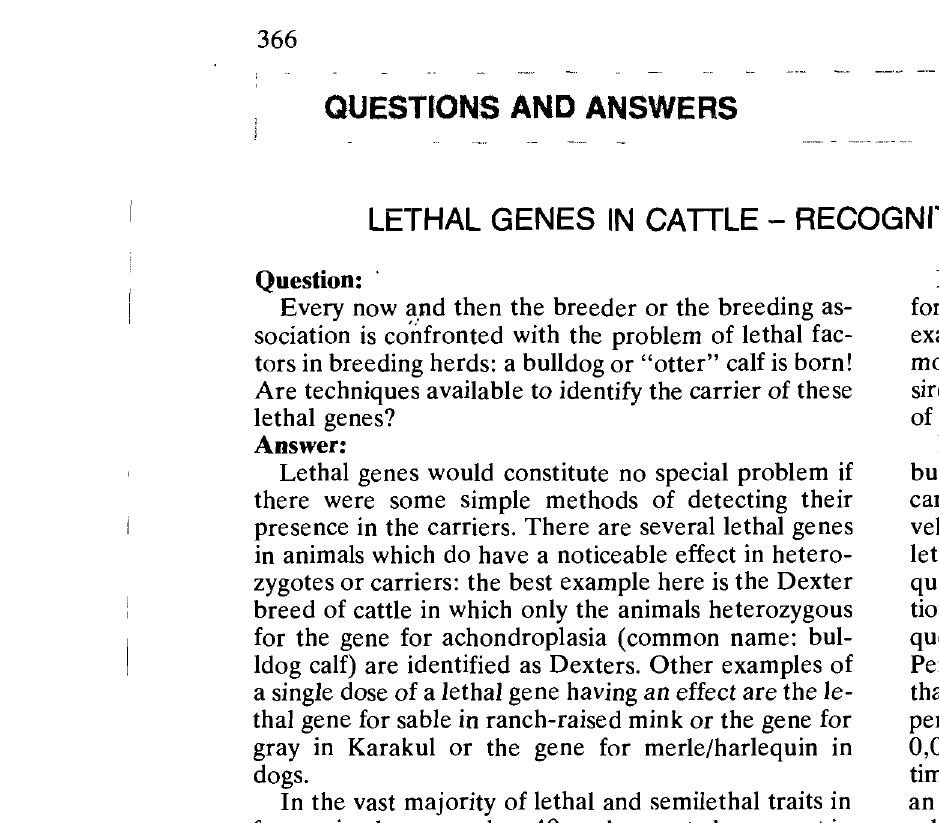
Table 2: "AUTOMATIC'! TESTING OF BULLS FOR